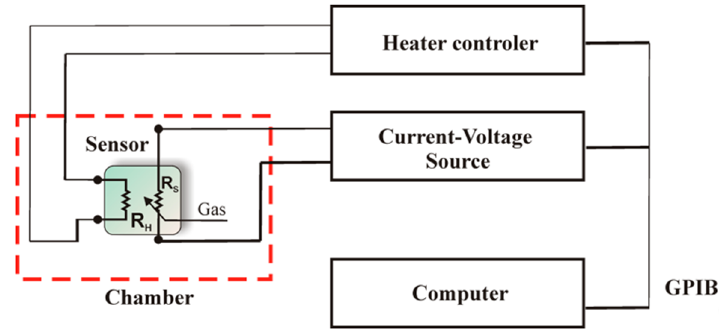
Figure 2. Schematic diagram of the construction of the measuring station used during the characterization of the sensors by the temperature-stimulated conductivity and voltammetric techniques.